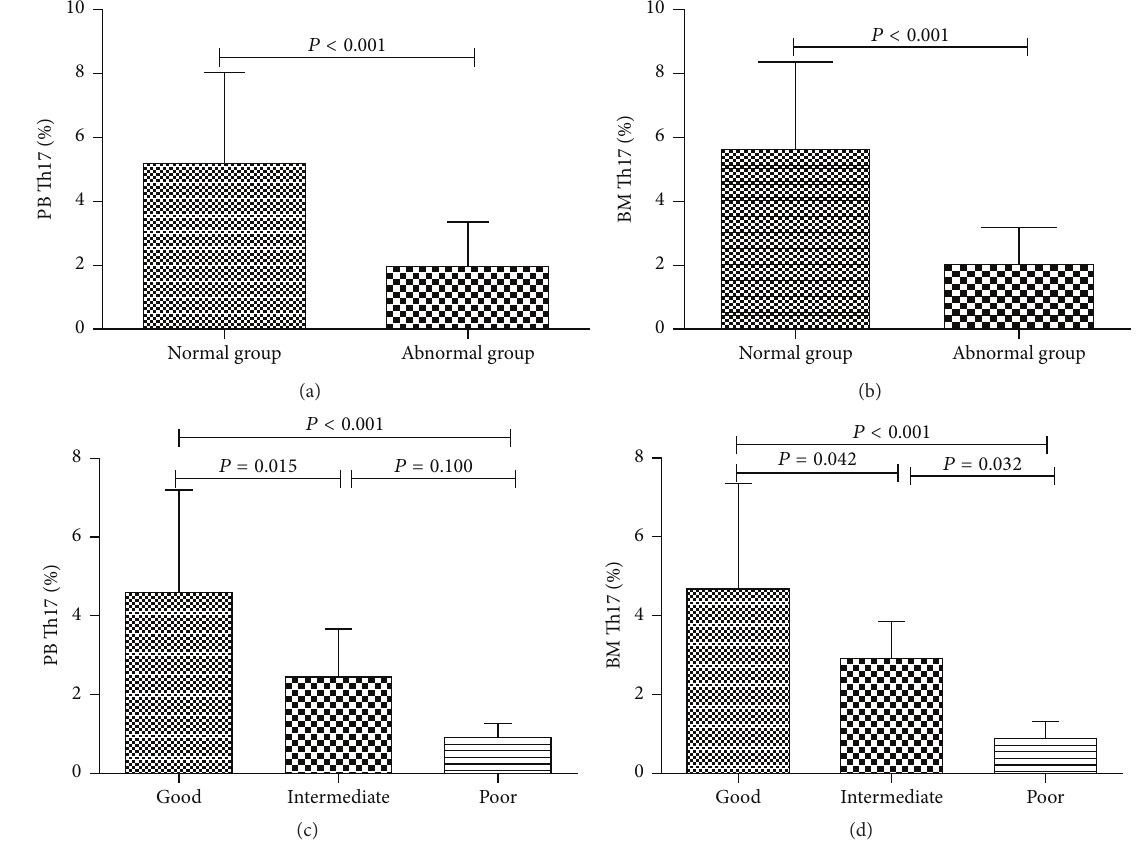
Figure 3: Th17 cell percentages differ among different karyotype groups. Differences of Th17 percentages between normal and abnormal karyotype groups were shown (a-b). PB and BM Th17 percentages in MDS patients with good, intermediate, and poor karyotypes were shown in (c) and